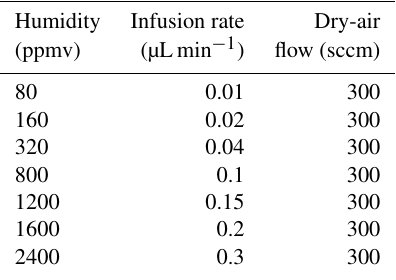
Table 3. Set points for the water infusion rate and dry-air flow at a temperature of 20 ◦